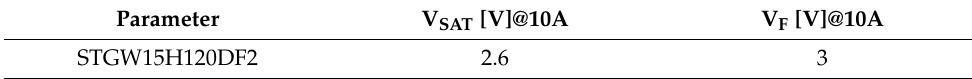
Table 1. Parameters of the IGBT STGW15H120DF2.